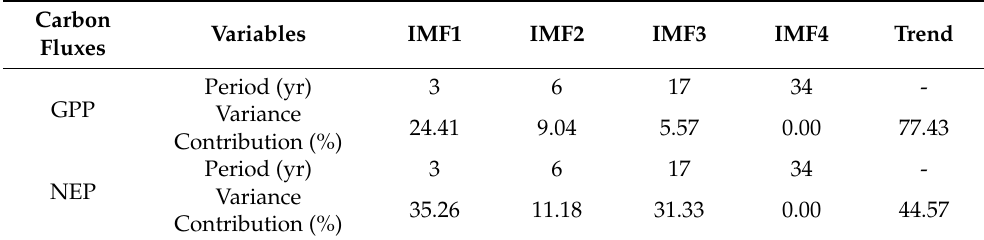
Figure 3. EEMD analysis of the average GPP ( a ) and NEP ( b ) changes during 1985–2018. IMF1–IMF 4 and Trend represent variations on different time scales and long-term trends, respectively. Table 3. Average periods and their variance contributions to carbon